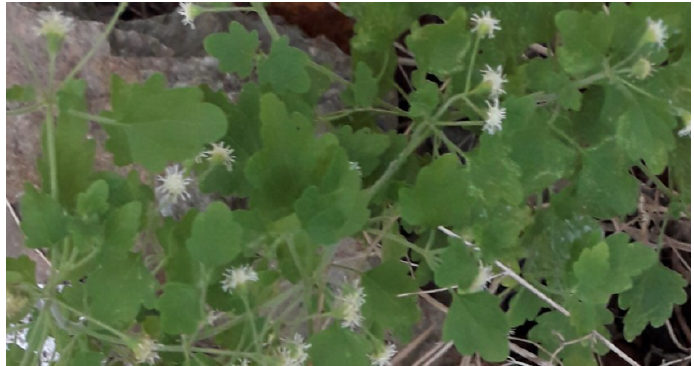
Figure 1. Phania matricarioides in a natural habitat. Picture taken by the authors during collection of the plant (March 2013, Bauta municipality, Artemisa, Cuba).